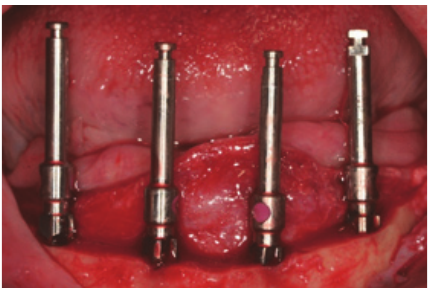
Figure 5: The intaglio surface of the mandibular interim denture is relined.